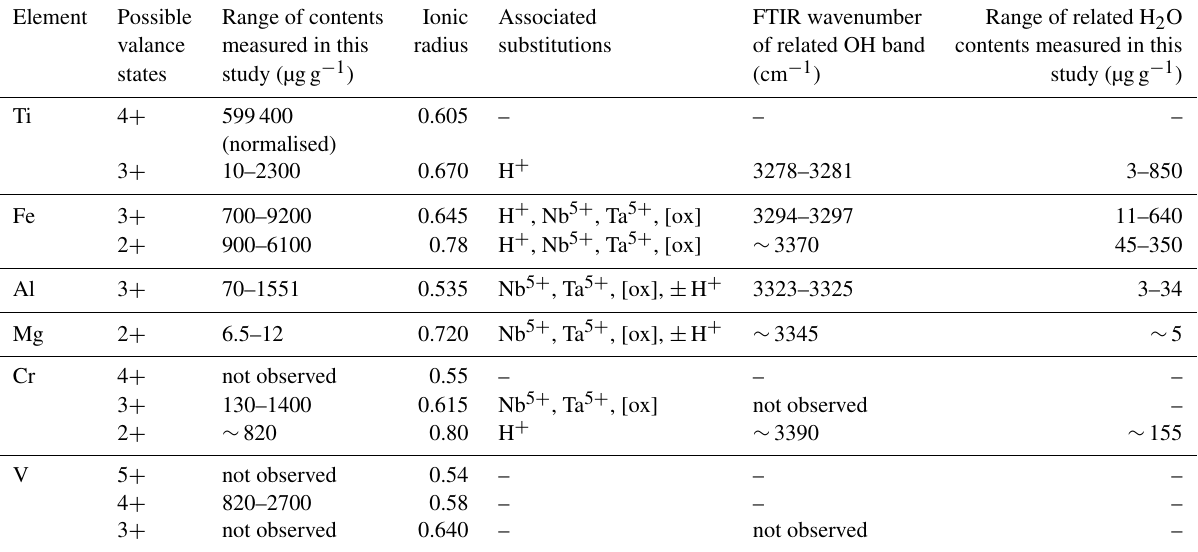
Table 6. Overview of measured trace-element contents, ionic radii, valence states, related H 2 O contents, and FTIR OH bands. [ox]: oxygen vacancies. Element Possible Range of contents Ionic Associated FTIR wavenumber Range of related H 2 O valance measured in this radius substitutions of related OH band contents measured in this states study (µgg − 1 ) (cm − 1 ) study (µgg − 1 ) 599400